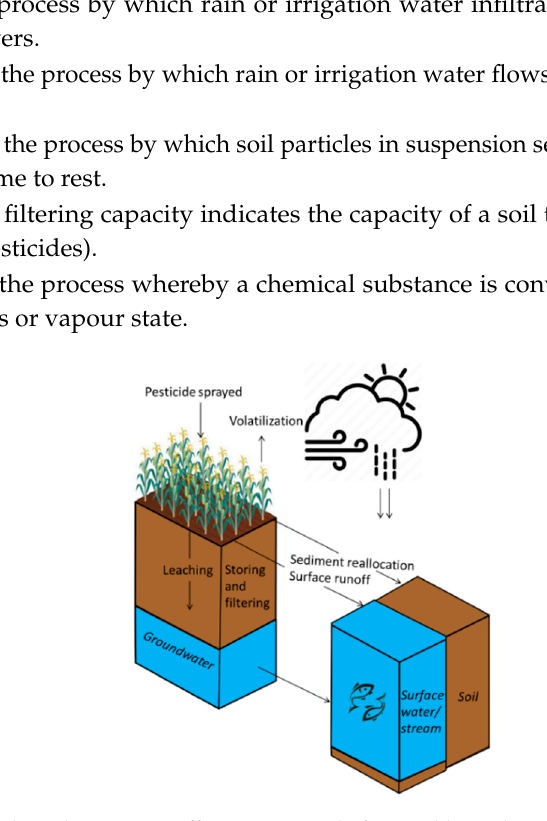
ff ecting pesticide fate and how they act in the Figure 1. The selected processes affecting pesticide fate and how they act in the environment. Figure 1. The selected processes a